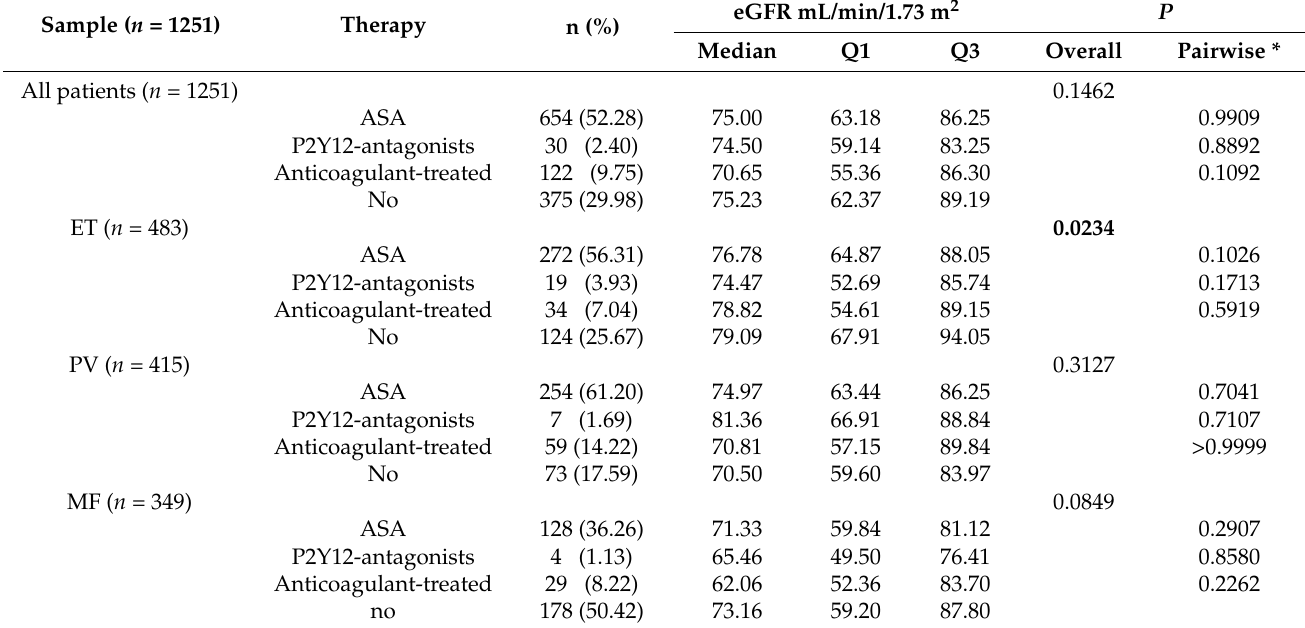
Table 6. Median eGFR in patients treated with ASA, P2Y12-antagonists, or anticoagulation therapy. Sample ( n =